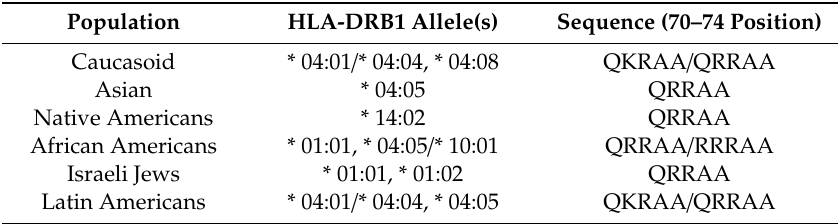
Table 1. Geographic distribution of rheumatoid arthritis-associated human leukocyte antigen ( HLA )- DRB1 shared epitope